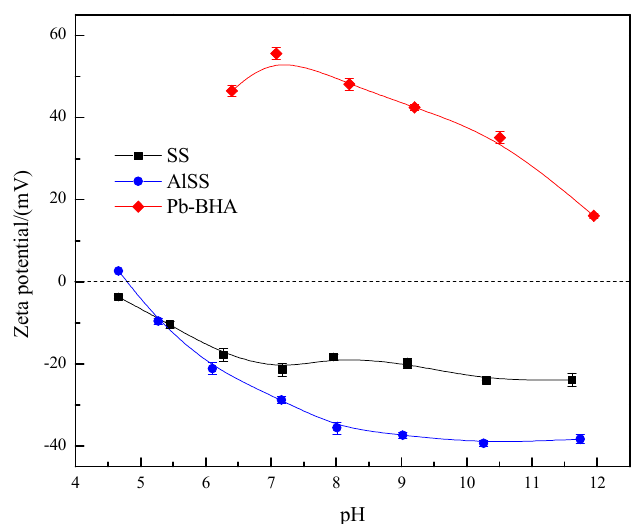
Figure 11. Zeta potential plots for Na 2 SiO 3 , Al-Na 2 SiO 3 polymer, and Pb-BHA complex ( C SS = C AlSS = 100 mg/L, C lead ion = 3 × 10 − 4 mol/L, C BHA = 1.5 × 10 − 4 mol/L).